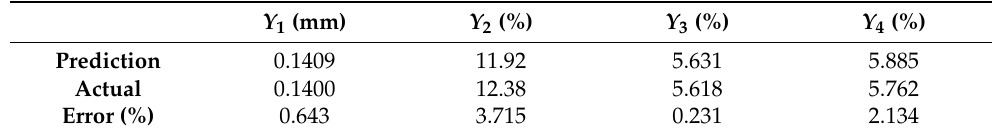
Table 13. Simulation results and prediction results.